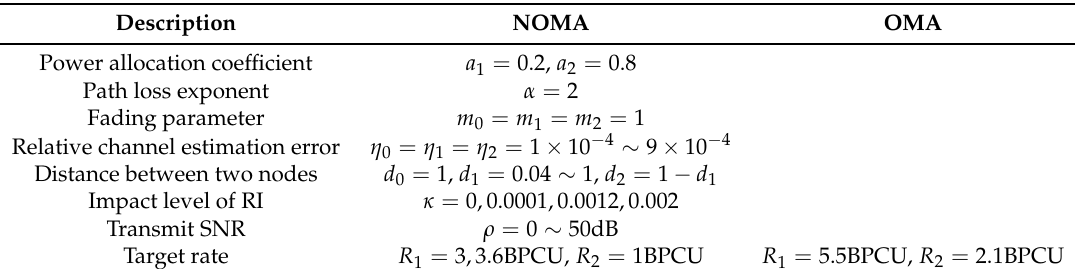
Table 3. The simulation parameters.